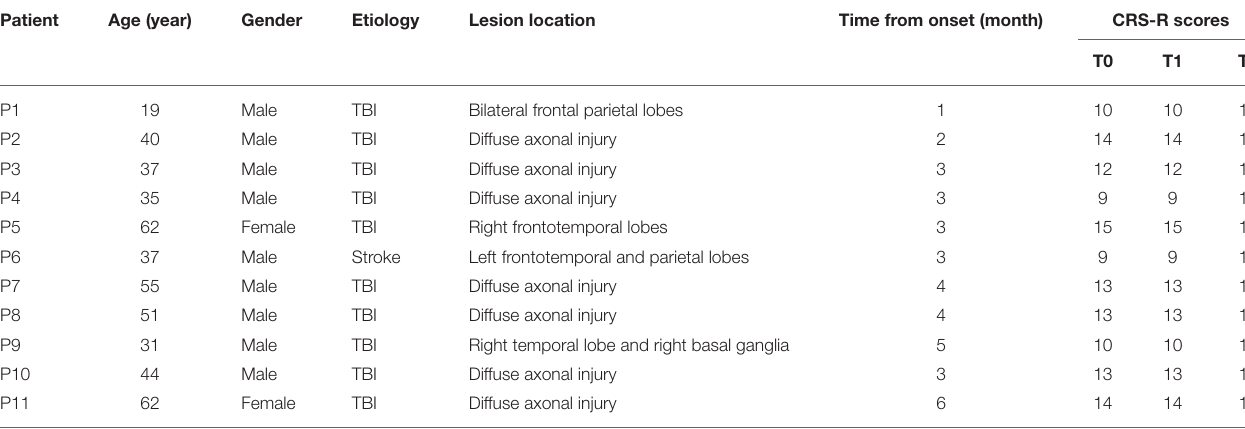
TABLE 1 | Demographic and clinical characteristics of the 11 patients with MCS. Patient Age (year)